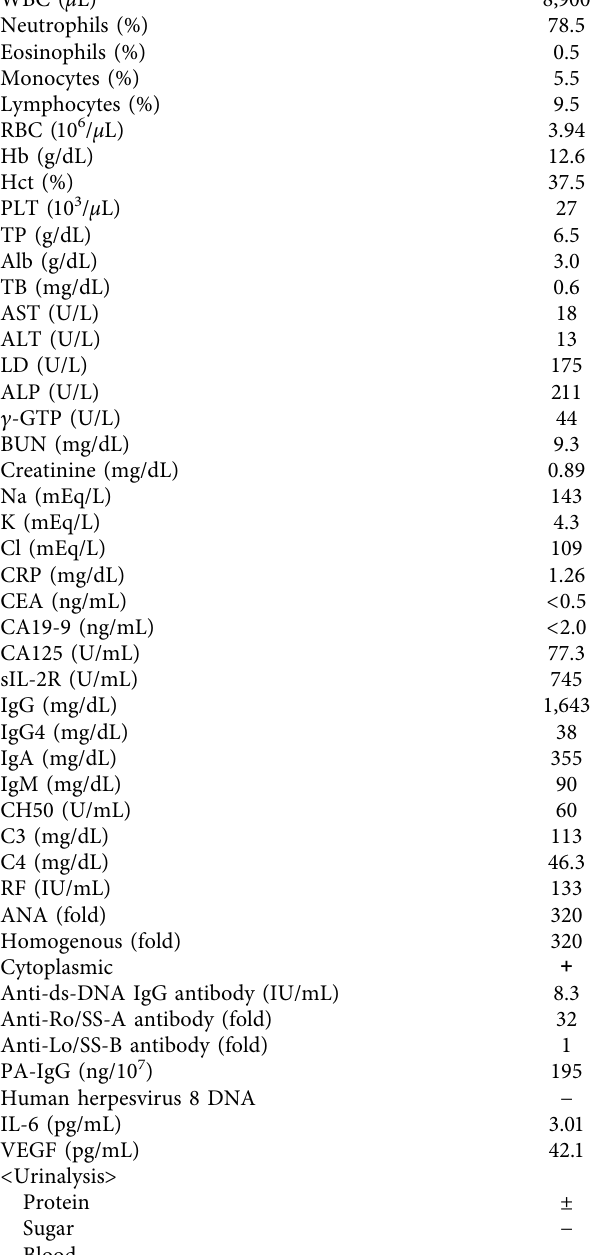
Table 1: Laboratory findings of the study patient on